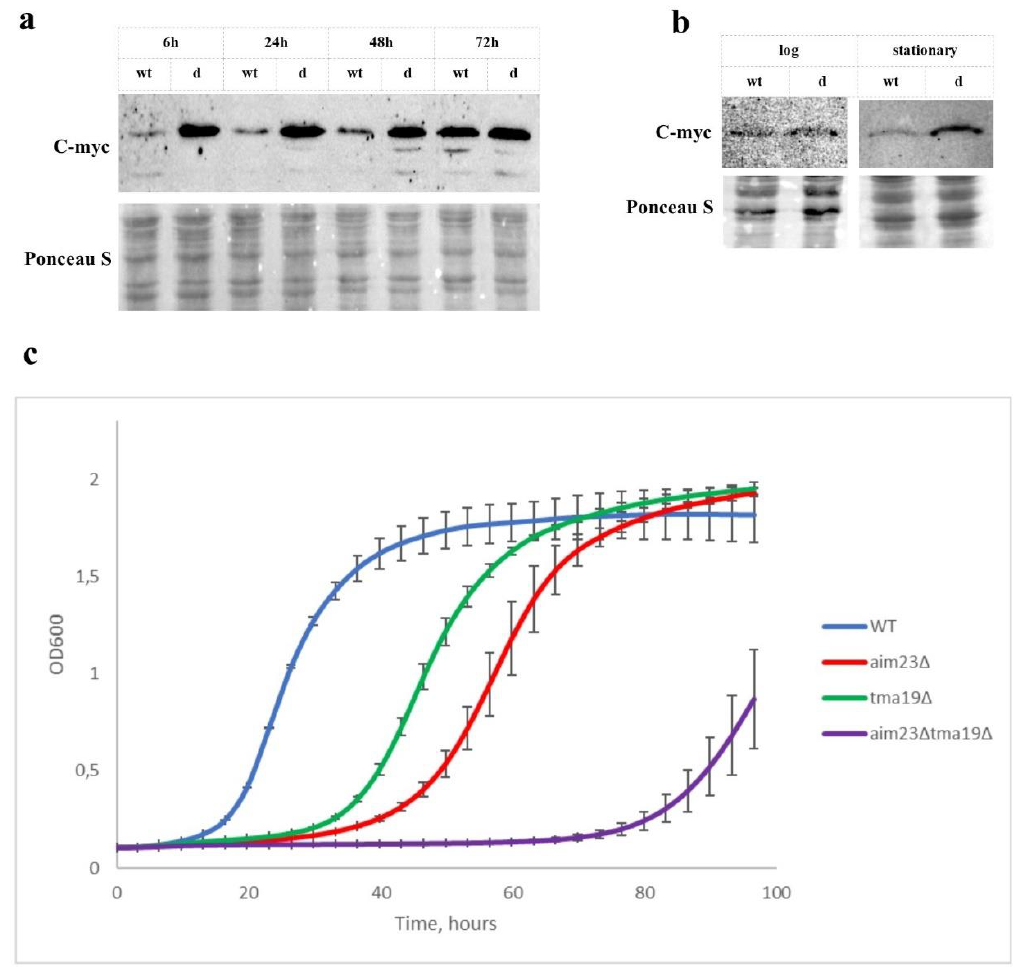
Figure 3. Tma19p is overproduced in aim23 ∆ strain during adaptation to respiratory growth. ( a ) Western-blot analysis of Tma19p steady-state levels at di ff erent time points of wild-type and aim23 ∆ strains grown on YPEG. In both strains, Tma19p was C-myc-tagged. Yeasts were grown overnight at YPD, washed twice with sterile water; for 6 h time point, amounts of cells equivalent to 1 OD were resuspended in 5 mL of YPEG and incubated at 30 ◦ C with vigorous shaking; for other time points yeasts were inoculated into 10 mL of YPEG up to OD 600 = 0.05 and incubated at the same conditions for indicated time points. (b) Steady-state levels of Tma19p at log-phase (OD 600 ~1) and late stationary phase (OD 600 ~5) of wild-type and aim23 ∆ strains’ growth on YPD. In both strains, Tma19p was C-myc-tagged. (c) Growth curves of wild-type, aim23 ∆ , tma19 ∆ , and aim23 ∆ tma19 ∆ on YPEG medium. Yeasts were grown overnight at YPD, washed twice with sterile water, and inoculated into 1 mL of YPEG in 24-well plates at OD 600 = 0.01; OD 600 measurements were performed for 96 h every 15 min; experiments were repeated three times, mean values +/ − SD are